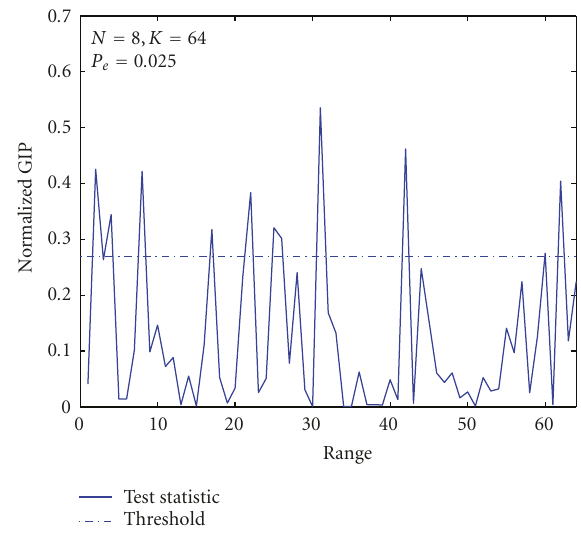
Figure 8: Normalized GIP statistic versus range in homogeneous K -distributed clutter, where ν = 0 . 5, μ = 1, N = 8, K = 64, and P e = 0 .